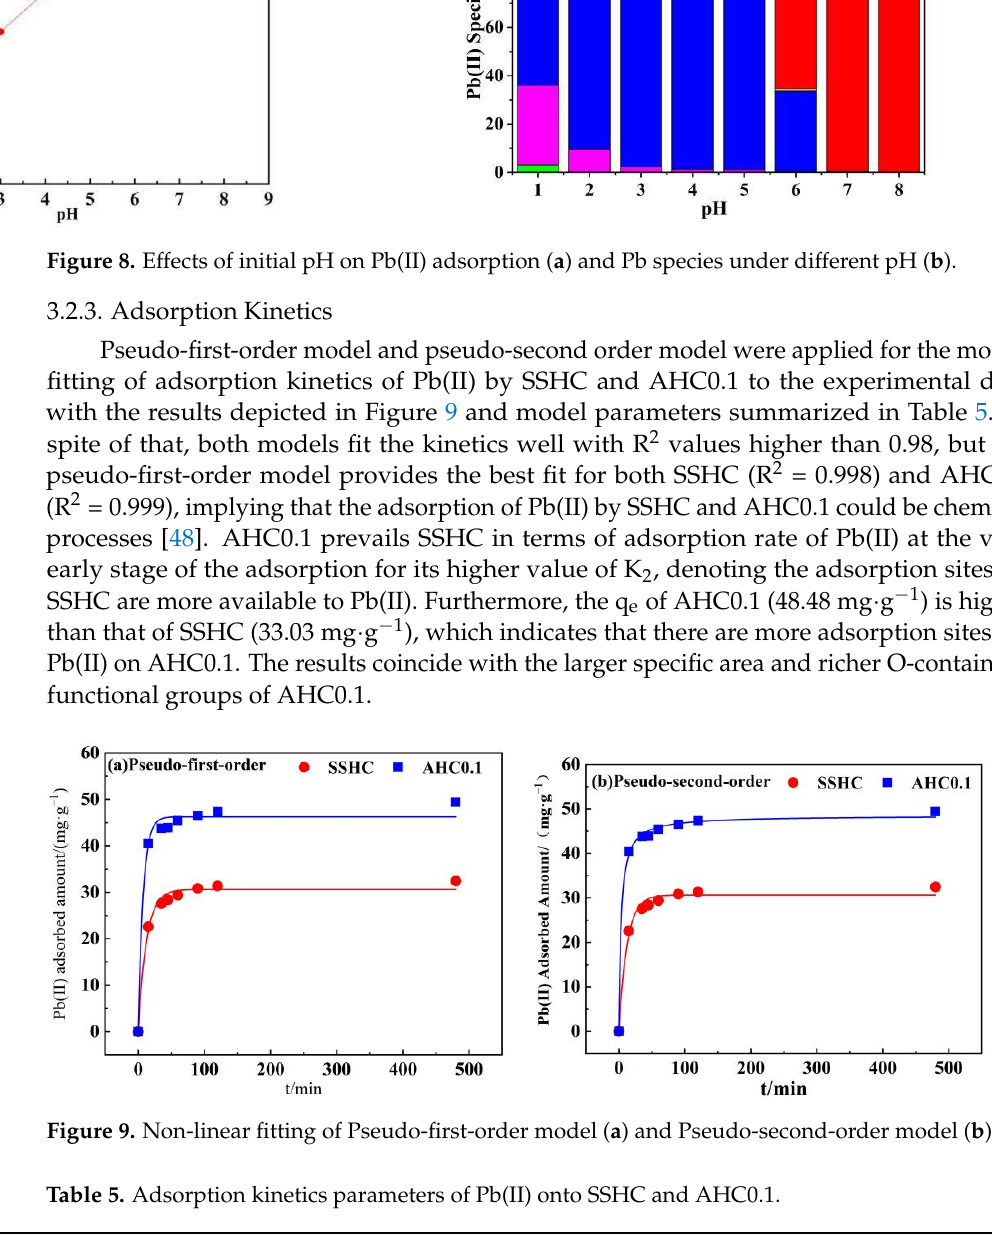
Figure 9. Non-linear fitting of Pseudo-first-order model ( a ) and Pseudo-second-order model ( b ). Table 5. Adsorption kinetics parameters of Pb(II) onto SSHC and